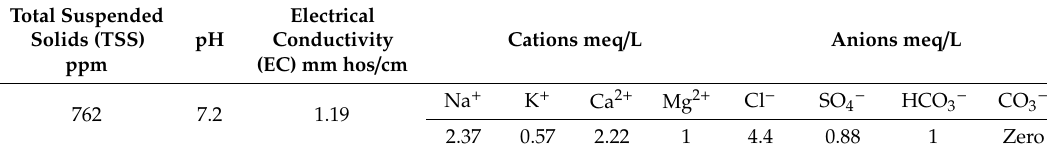
Table 3. Chemical properties of